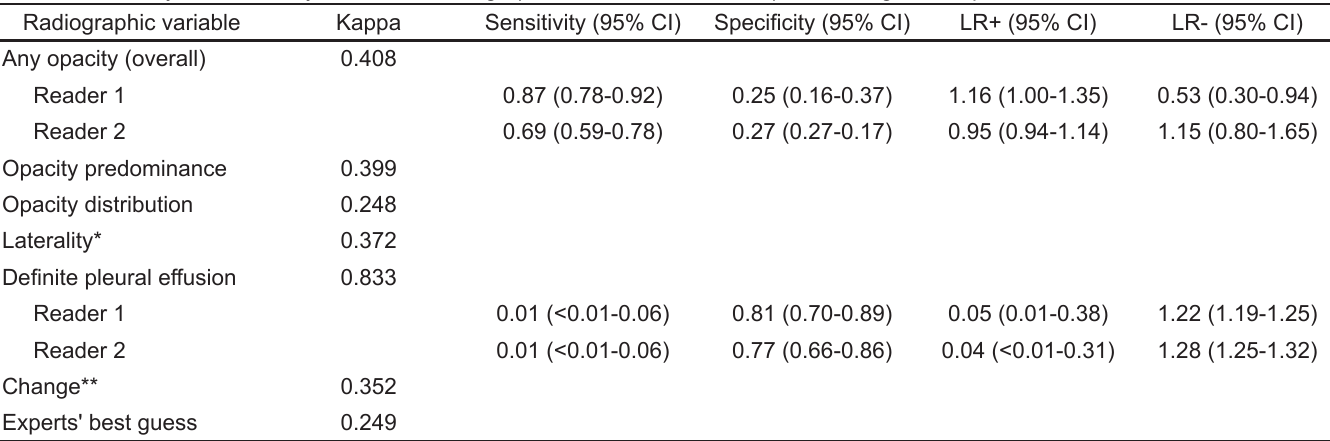
Table 2. Reliability and accuracy of different radiographic characteristic and experts’ best guess to predict COVID-19 status.